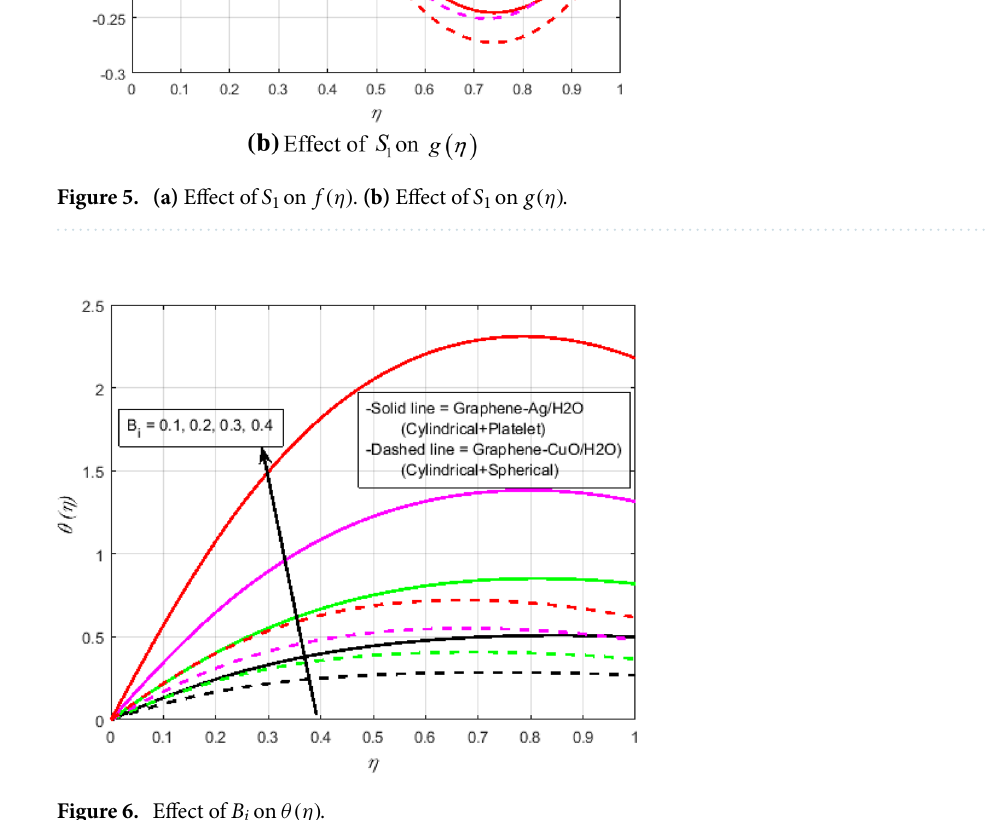
Figure 6. Effect of B i on θ(η)